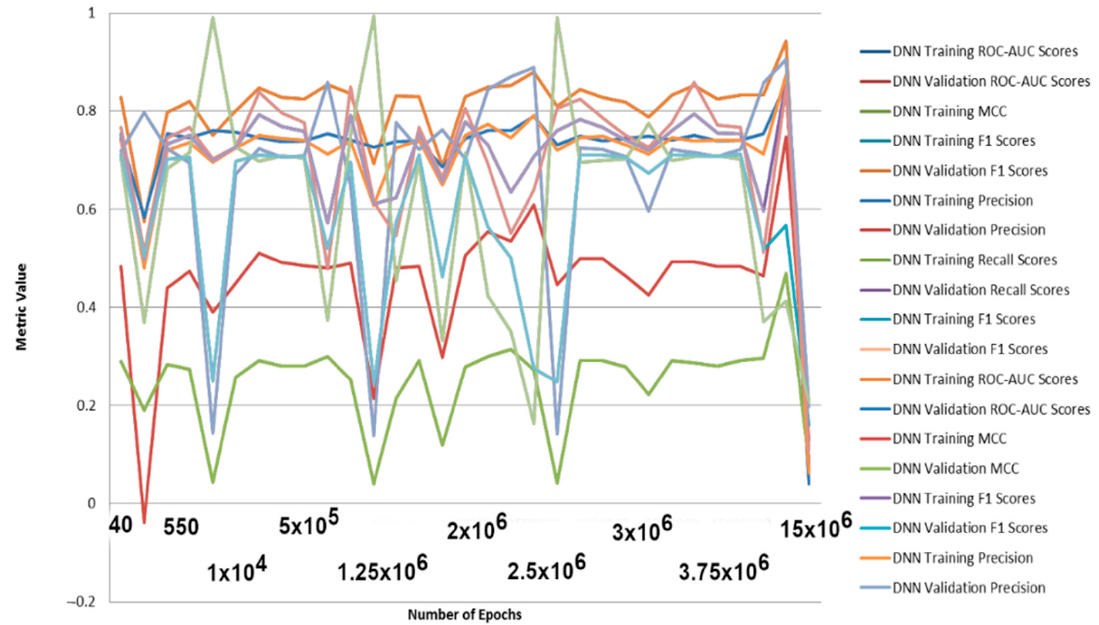
Figure 5. Metrics for different Deep Learning models with varying number of epochs. MCC = Matthews correlation coefficients for balanced training test and validation test.